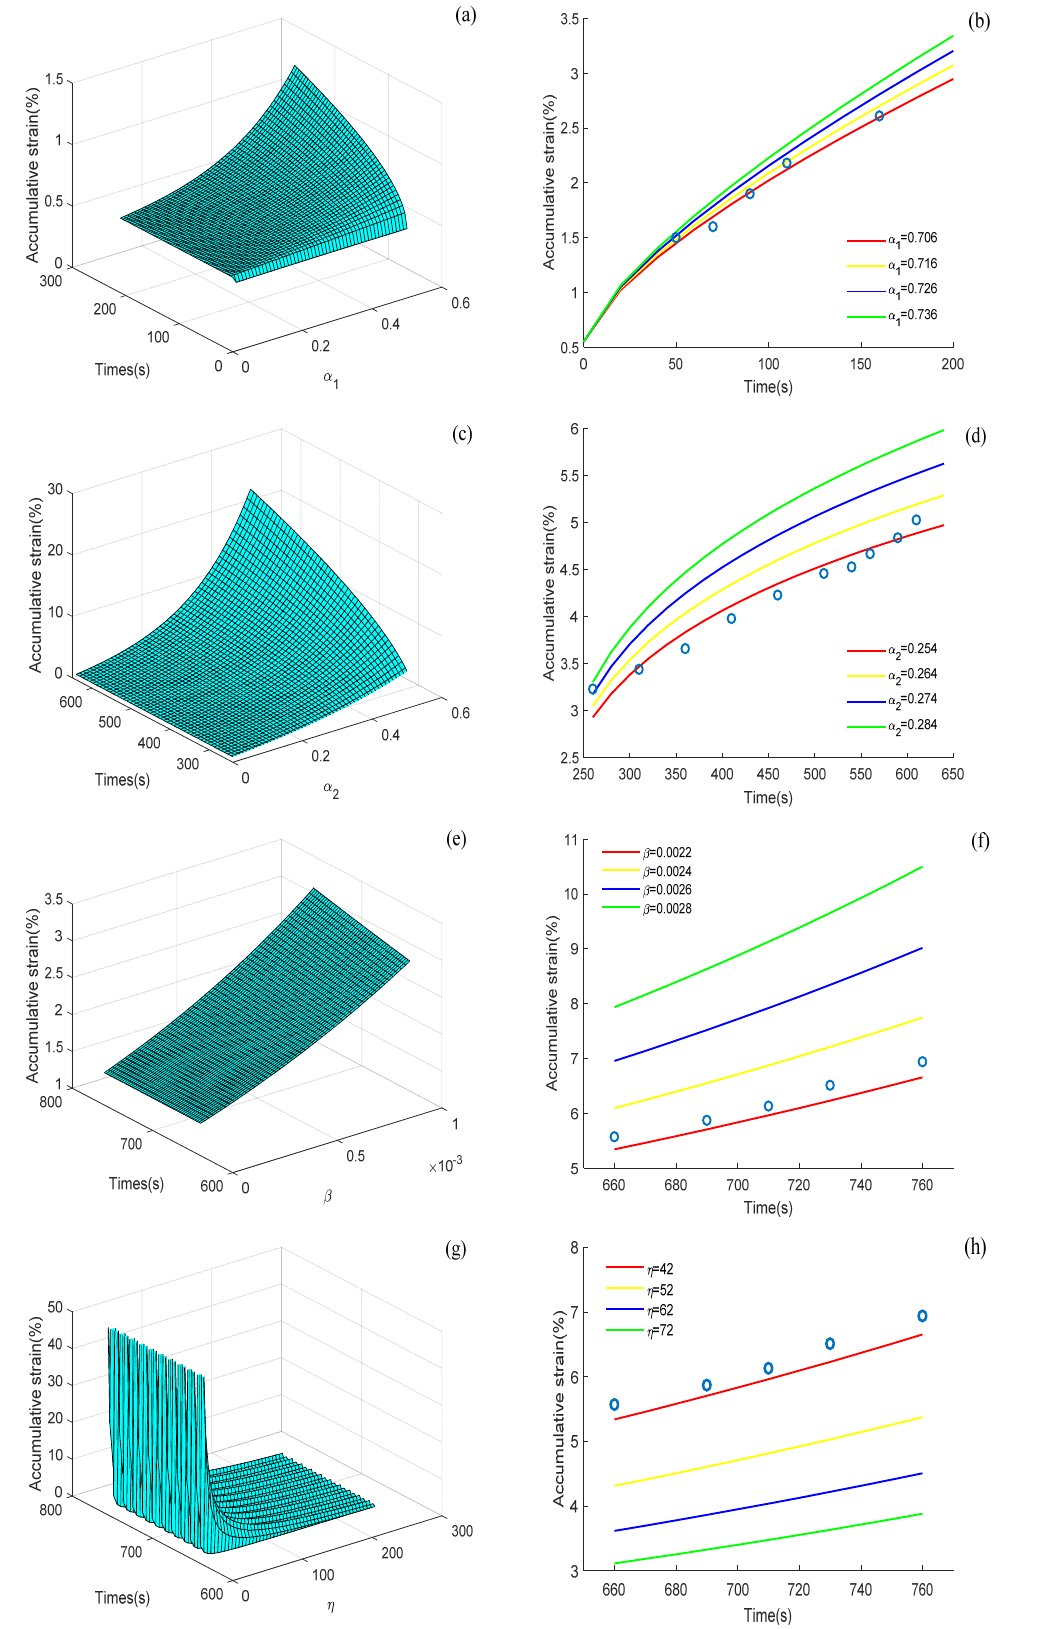
Figure 14. Sensitivity analysis of parameters 𝛼 (cid:2869) , 𝛼 (cid:2870) , 𝛽 and 𝜂 of the constitutive model.